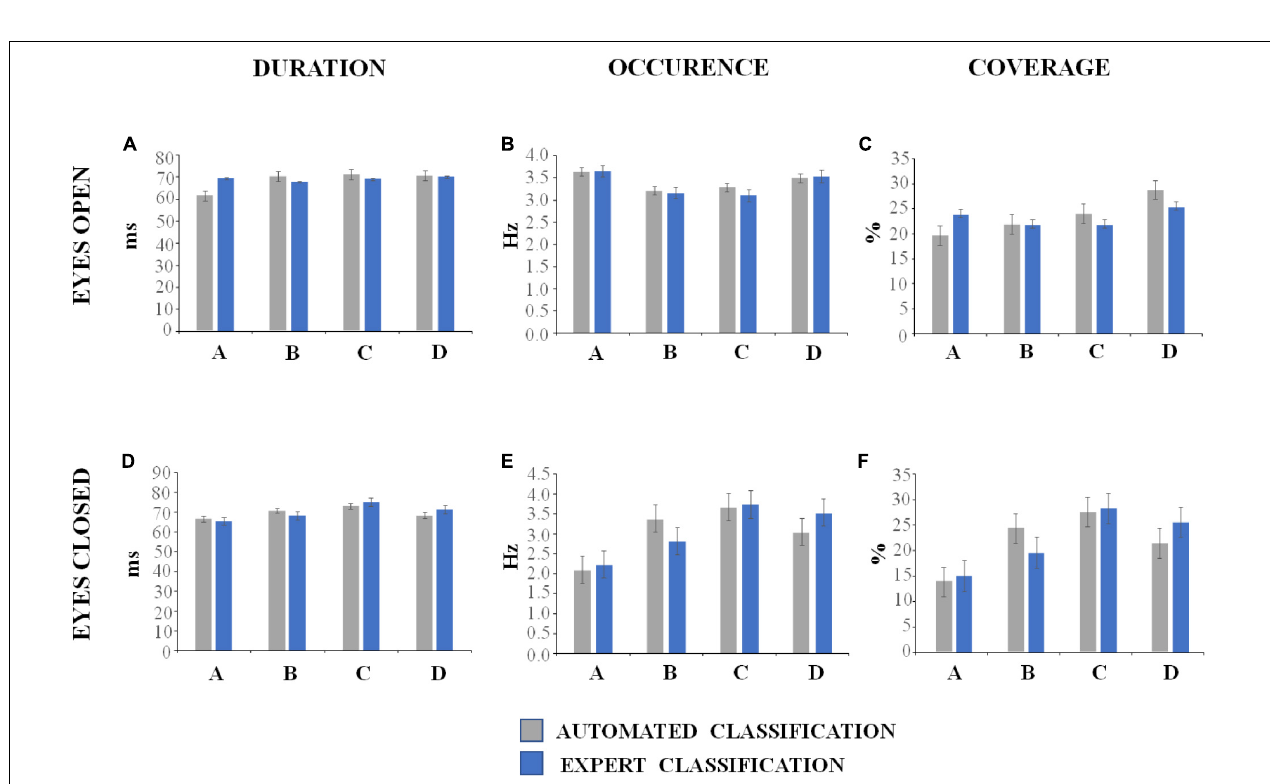
FIGURE 4 | Descriptive statistics of microstate metrics (mean values with standard errors). The labels of the global microstate templates are given in the X -axes of (A–F) .